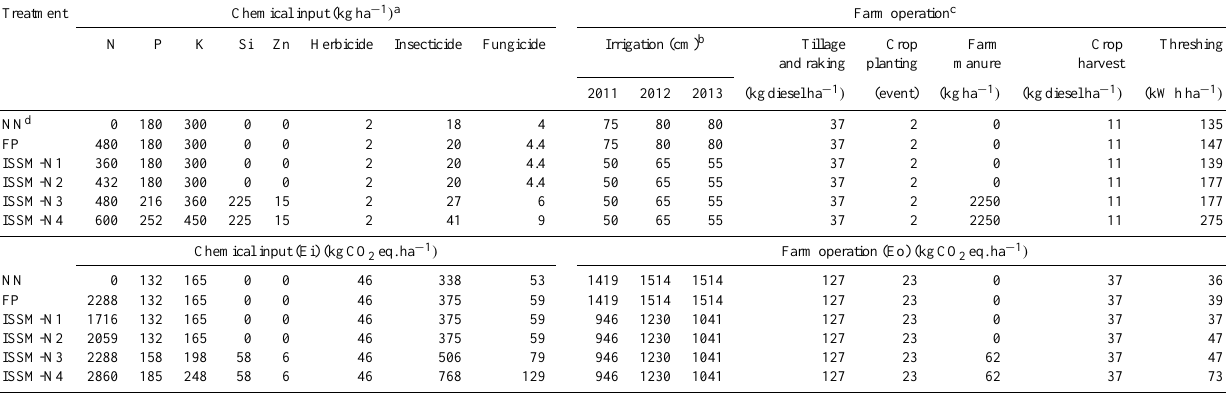
Table 5. Agricultural management practices for chemical input and farm operation and contributions to carbon dioxide equivalents (kgCO 2 eq.ha − 1 yr − 1 ) in the annual rice-wheat rotations from 2011 to 2014 (chemical input and farm operation used in each year were similar except for irrigation